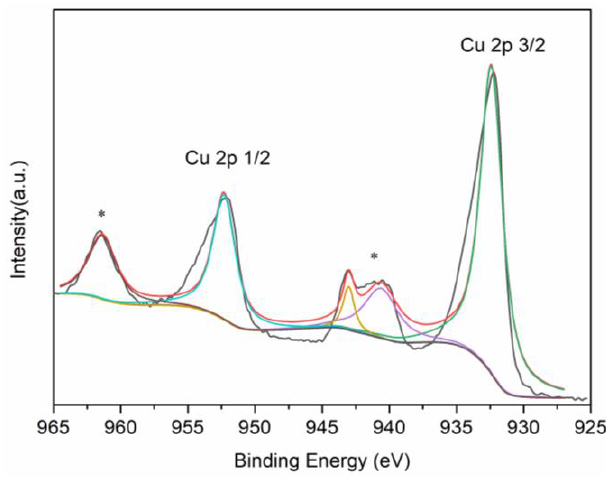
Figure 4. The Cu2p XPS spectrum of CuO microspheres assembled with nano-sheets.